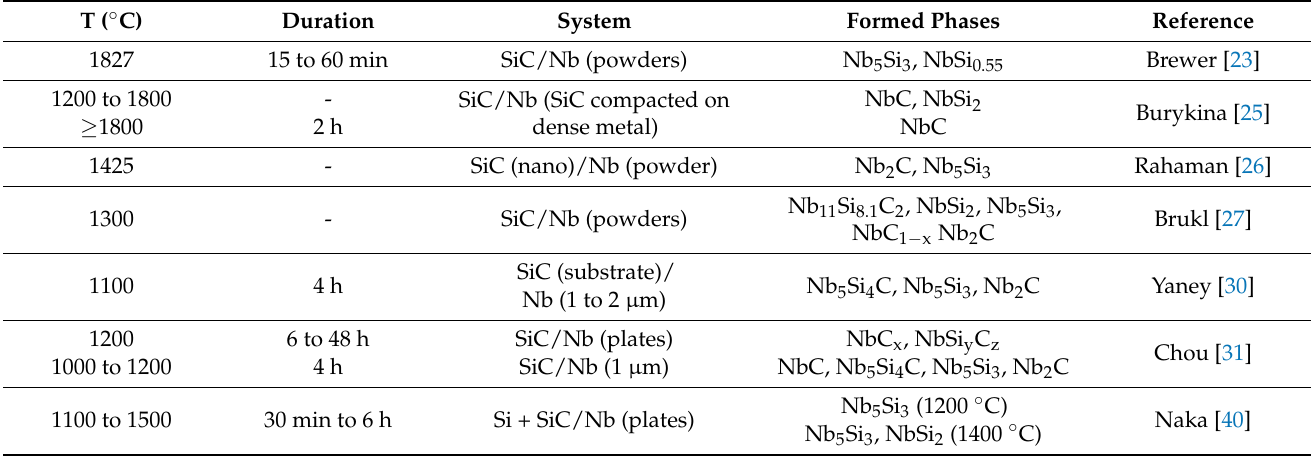
Figure 3. ( a ) Isothermal sections of the ternary Nb–Si–C system at 1100 ◦ C. Reprinted with permission from ref. [30]. 1990, Springer Nature; and ( b ) Ta–Si–C system at 1000 ◦ C. Reprinted with permission from ref. [33]. 1993–1994, Elsevier. Table 1. Composition of the reaction zone in the Nb–Si–C system as a function of the system and the annealing